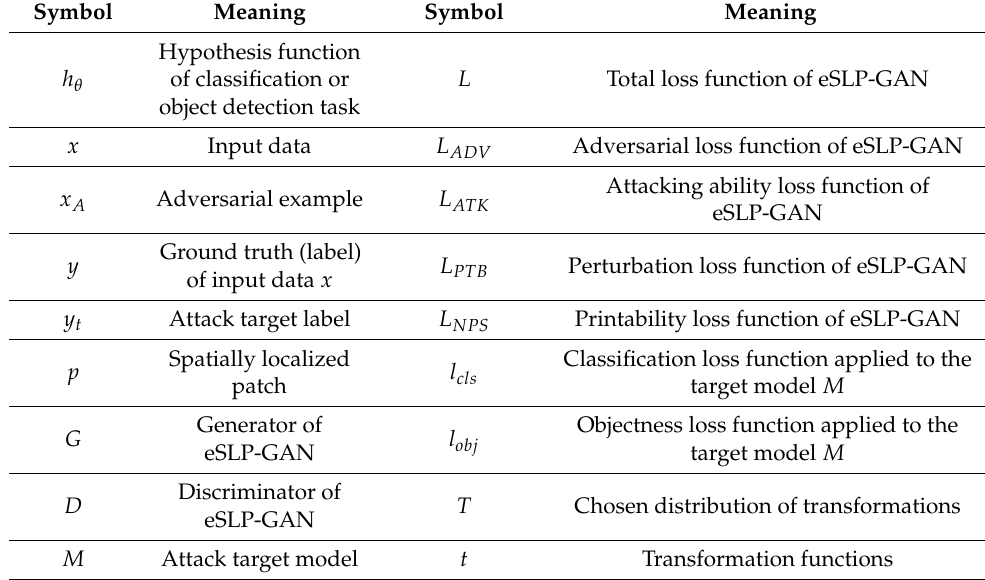
Table 1. List of symbols in this